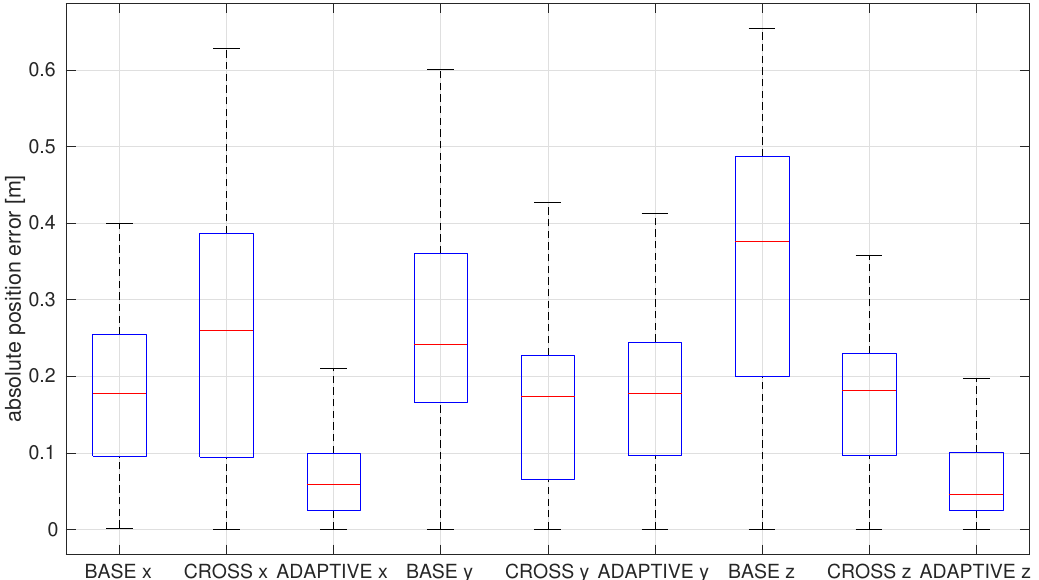
Figure 11. Box plot of absolute estimation error of position of the EuRoC V1 medium dataset by the latency compensated